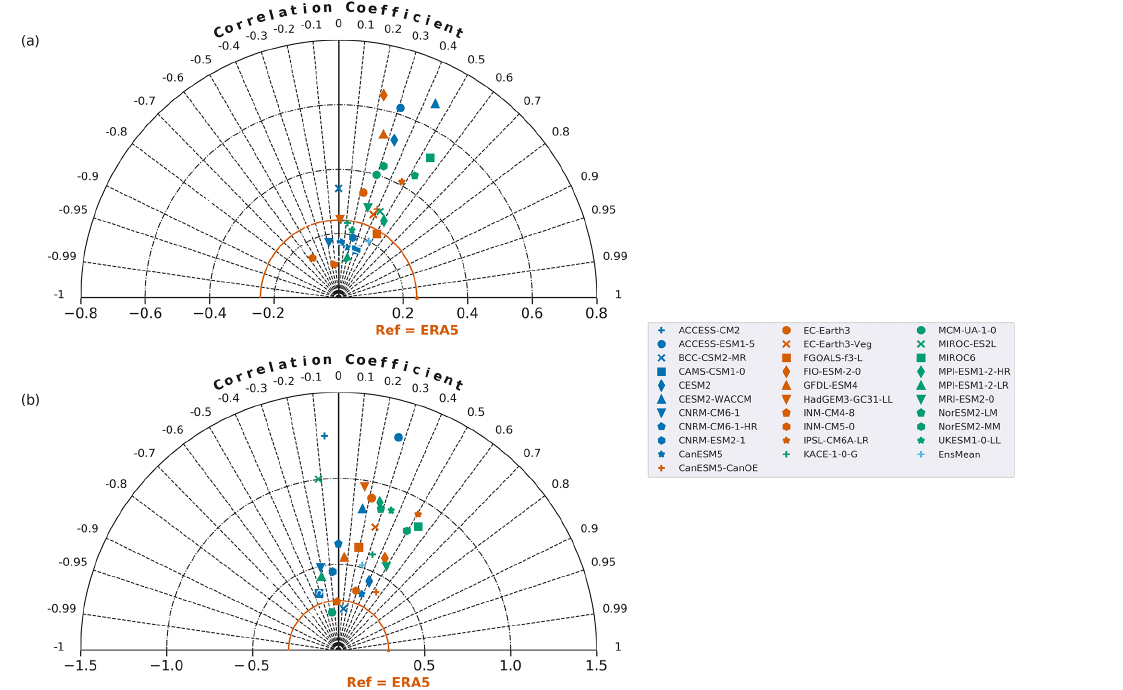
Figure 5. (a) Taylor diagram of the JAS spatial rainfall pattern obtained in Fig. 4 over the West African box (magenta box in the maps in Fig. 4). (b) Same as in (a) but for the tropical Atlantic box 2 (black box in the maps in Fig. 4). ERA5 is used as the reference in (a) and (b)